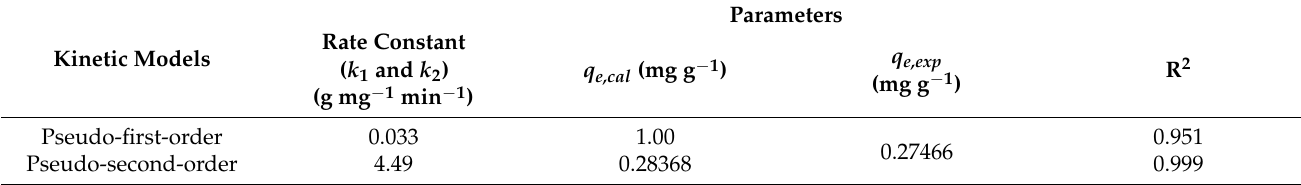
Table 1. Kinetic parameters of Cd (II) ion adsorption onto starch-based AC.